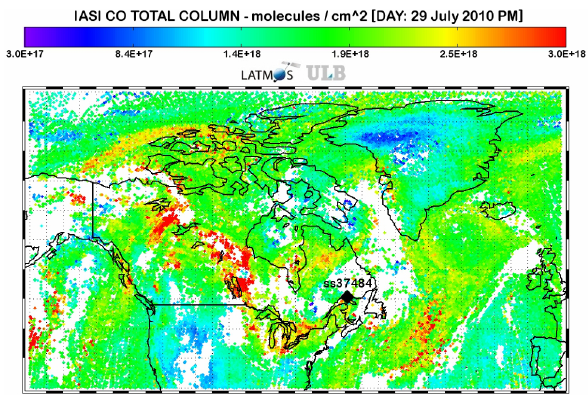
Fig. 2. IASI CO total column data for the evening orbit over North America on 29 July 2010. The figure shows the biomass burning outflow from numerous sources including Boreal fires in northern Saskatchewan and the Northwest Territories in Canada, a Siberian plume making its way eastward over Arctic Canada and a plume originating from China off the west coast of North America. The plume of elevated CO sampled by ss37484 in Fig. 1 is clearly visible over Maritime Canada and the path of the CO outflow emulates the HYSPLIT backtrajectory where the plume follows a southeasterly path from the source toward the Great Lakes and from there turns northeast in the direction of the Maritimes.